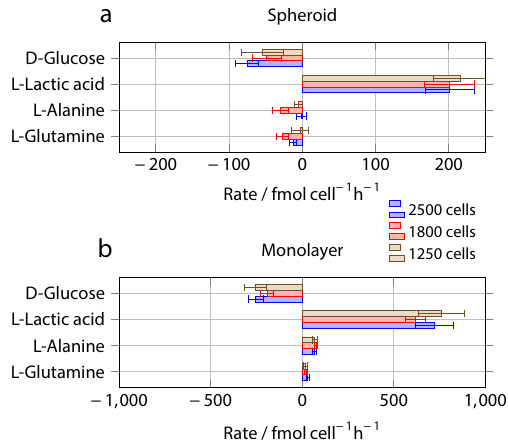
Figure 8. Production (positive) or consumption (negative) rates per cell, obtained from the NMR spectra for a single spheroid (a) and monolayer culture (b) . The scale for the spheroid results is expanded by a factor of 4 compared to the monolayer data. Error bars represent the standard deviation from three separate experiments, and take into account the errors in cell numbers as well as fabrication tolerance error in the sample